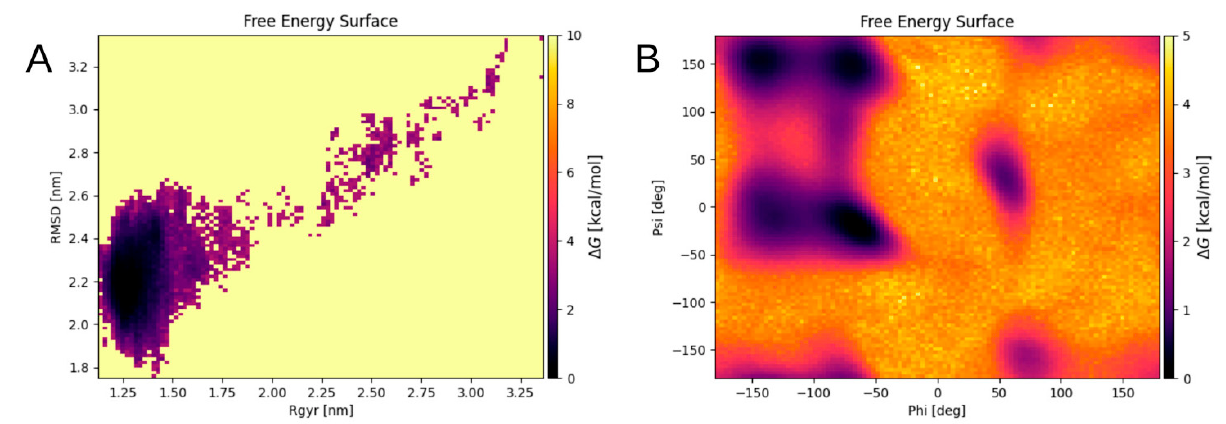
Figure 8. Energy landscape of the A β 16 quadromer with two zinc ions in the coordination centers of dimers after 100 ns of REMD simulation with 32 replicas, in the temperature range of 300–382.84 K. ( A ) Gibbs free energy surface as a function of the RMSD value and the gyration radius of the A β 16 conglomerate and ( B ) of the values of phi and psi angles for A β 16 molecule.